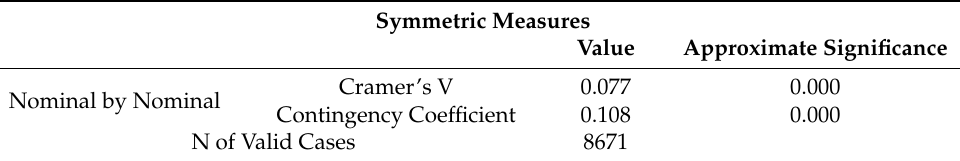
Table 18. Strength of dependence between variables. Source: own